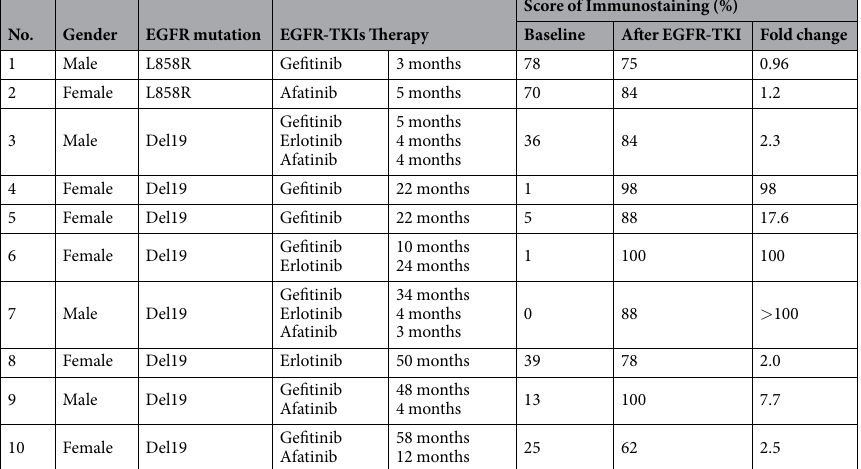
Table 3. ANKRD1 expression levels in lung specimens changed after EGFR-TKI therapy.